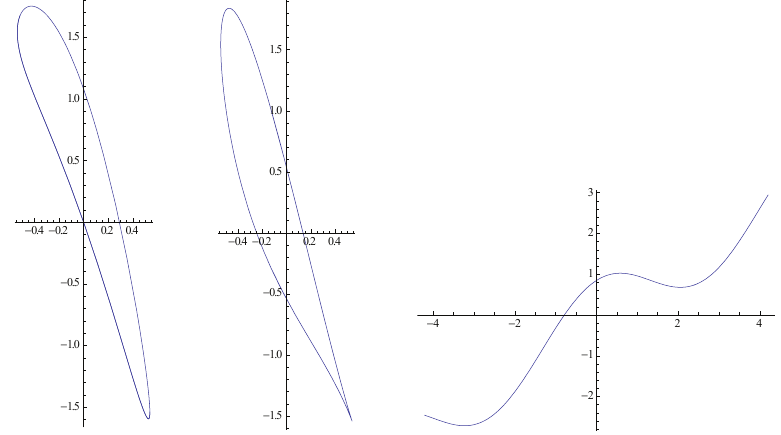
Fig. 3. A dual circular helix is a triple product curve of above three curves in D